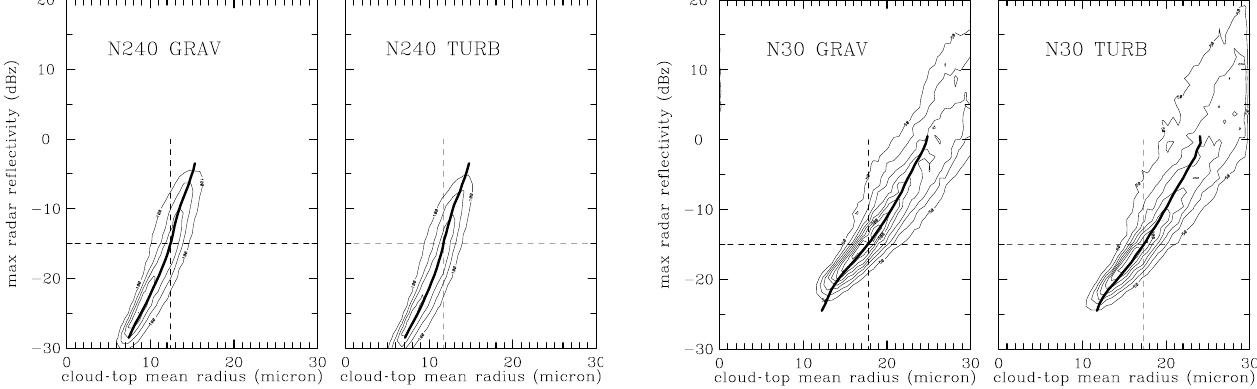
Figure 10. As Fig. 9, but for the N30 cases. The contour interval and the starting contour are 50.